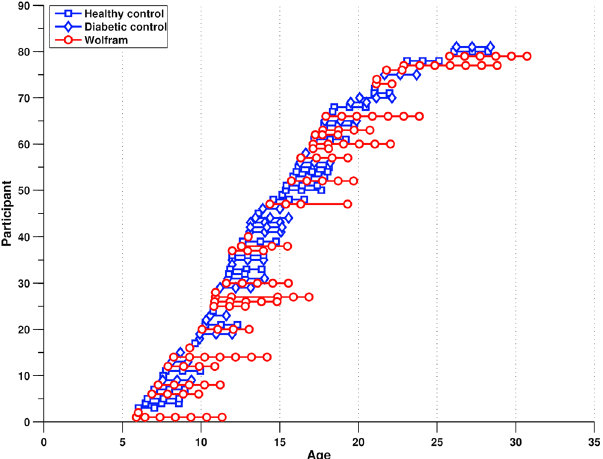
Figure 1. Ages of the 81 participants at each of their MRI scans. Each row on the Y-axis indicates an individual participant and symbols (connected by a line) indicate the participant’s age at each session (X-axis). Wolfram participants are shown in red and controls are shown in